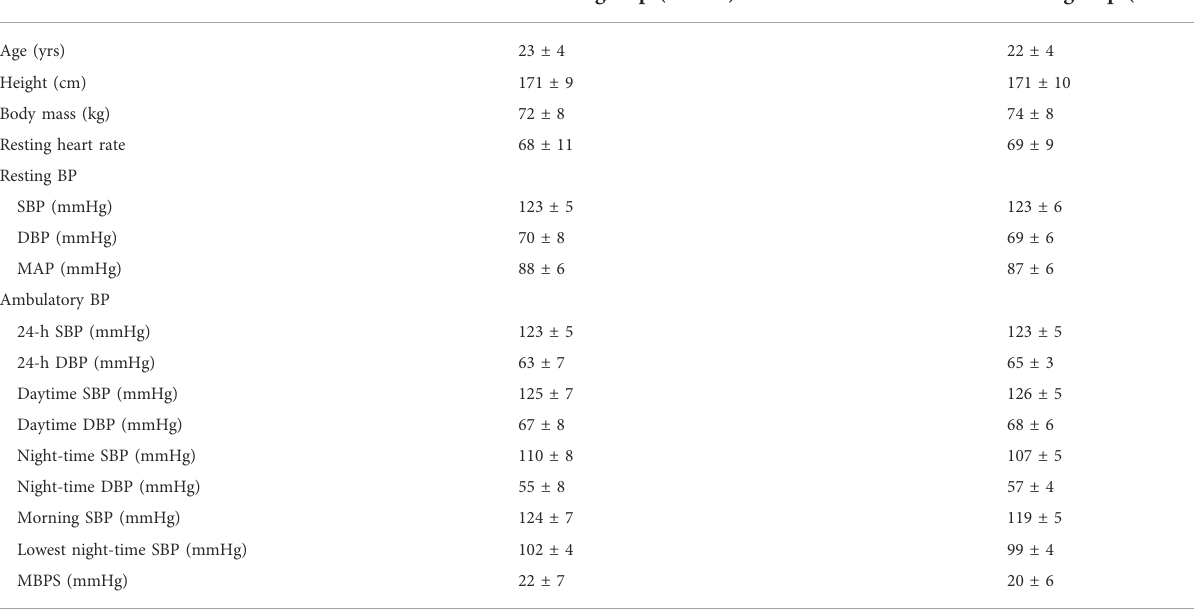
TABLE 1 Participant baseline demographic and ambulatory